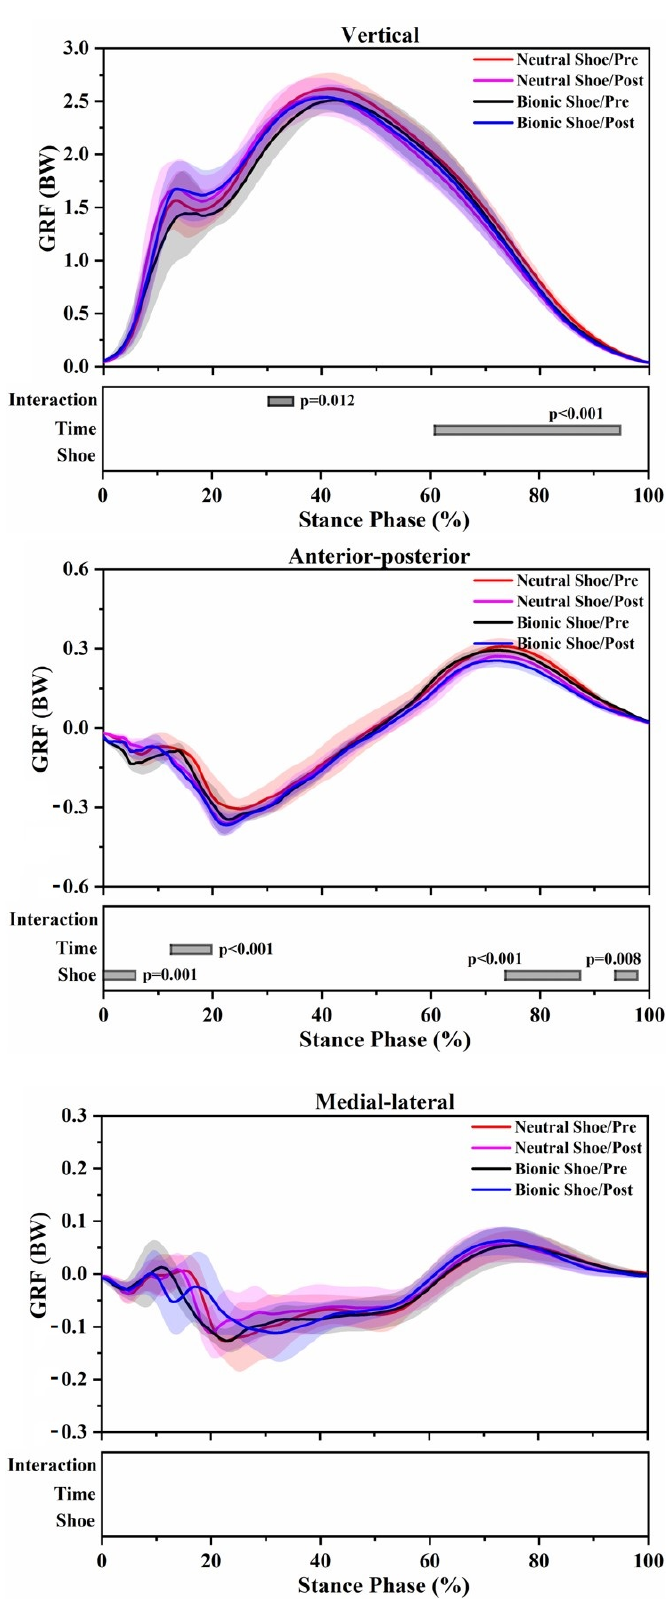
Figure 3. Ground reaction forces (GRFs) waveforms of the mean (SD) over the stance period of four running tests. Significant main effects of the shoe conditions, 5 km run, and interaction effects ( p < 0.05) are highlighted (grey horizontal bars at the bottom of the figure) during consistent periods from SPM1d analyses.